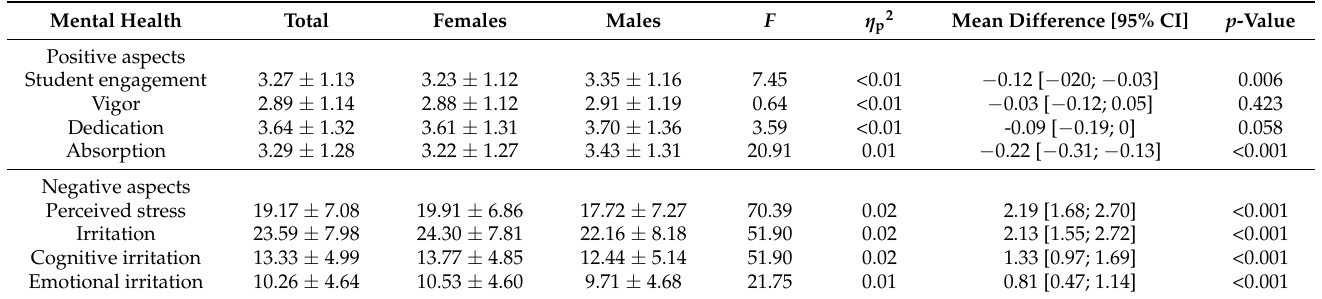
Table 2. Student mental health by sex for continuous variables.